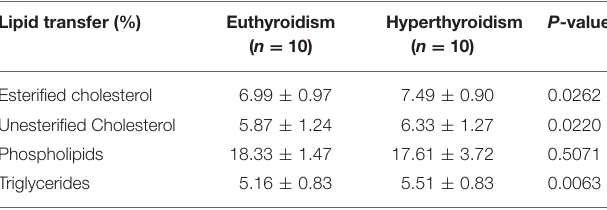
TABLE 2 | Lipid transfers to HDL in euthyroidism and subclinical hyperthyroidism. Lipid transfer